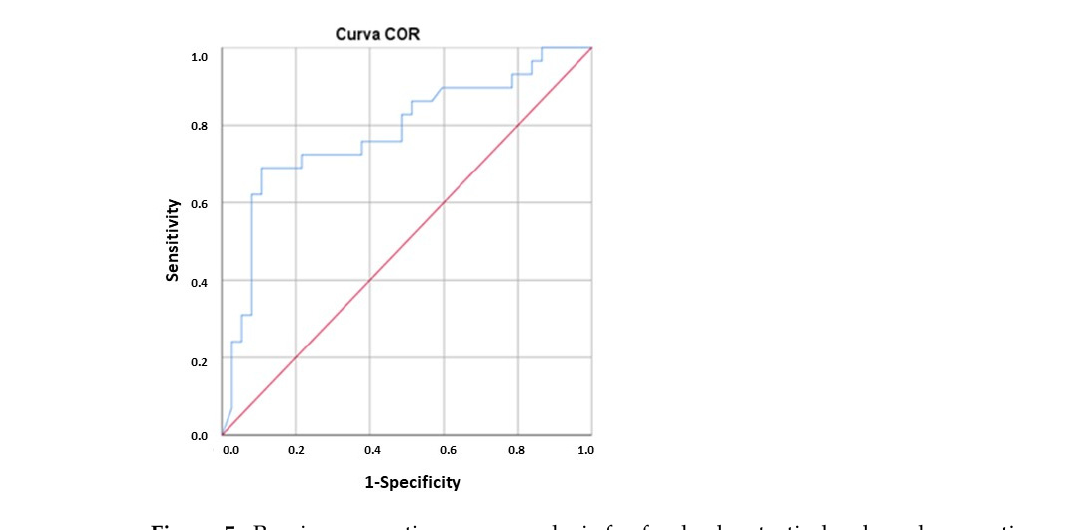
Figure 5. Receiver operating curve analysis for fecal calprotectin levels and magnetic resonance enterography lesions.